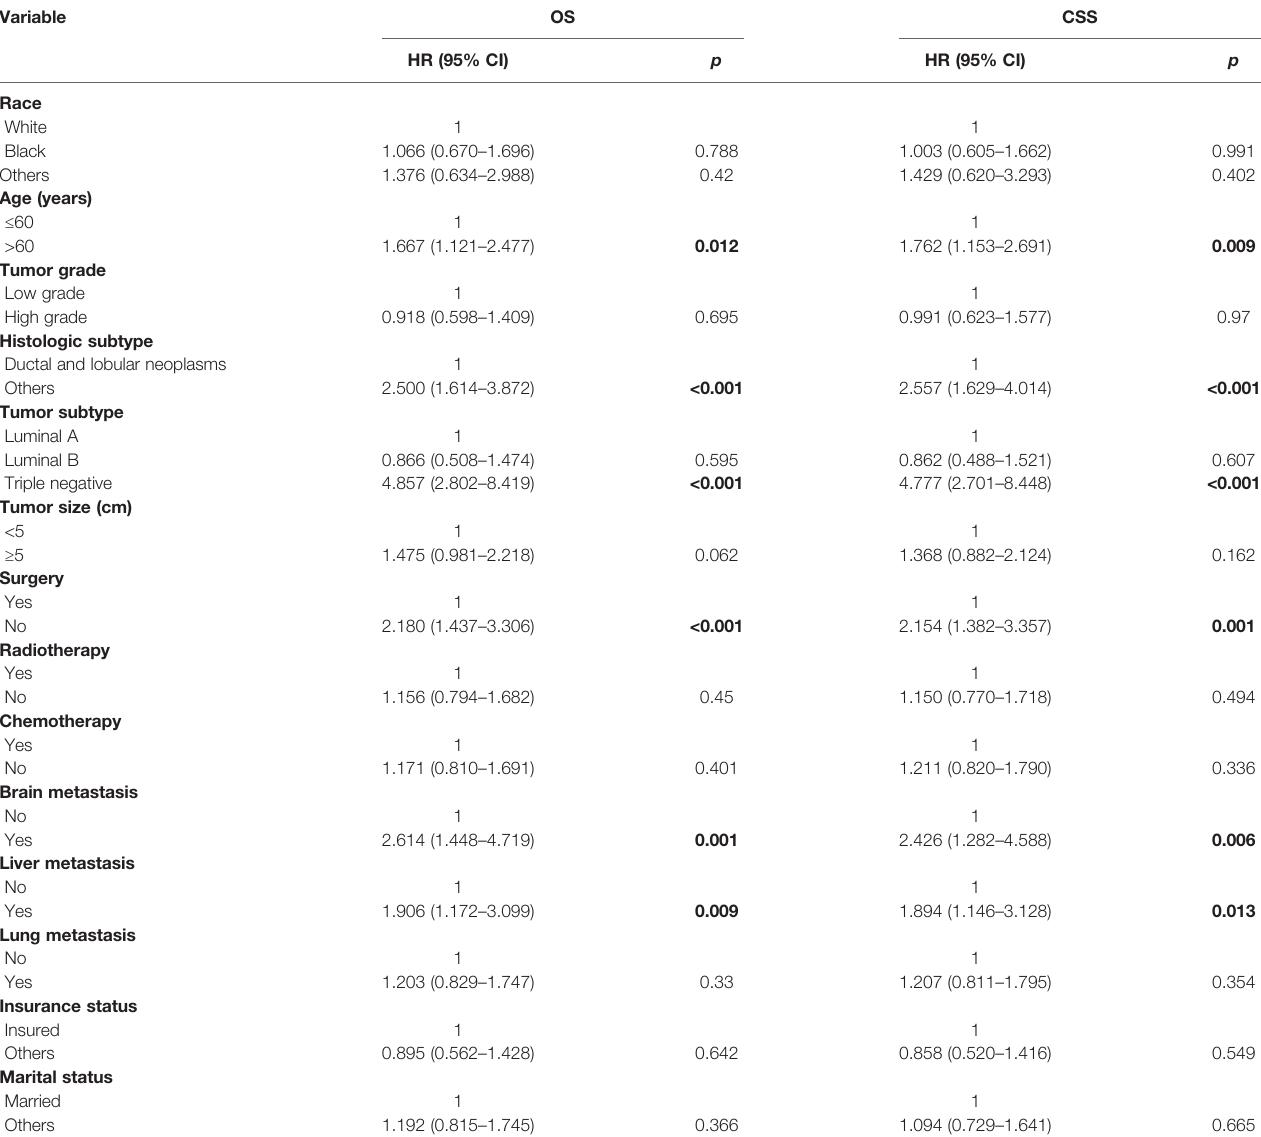
TABLE 2 | Univariate Cox analysis of variables in male breast cancer with bone